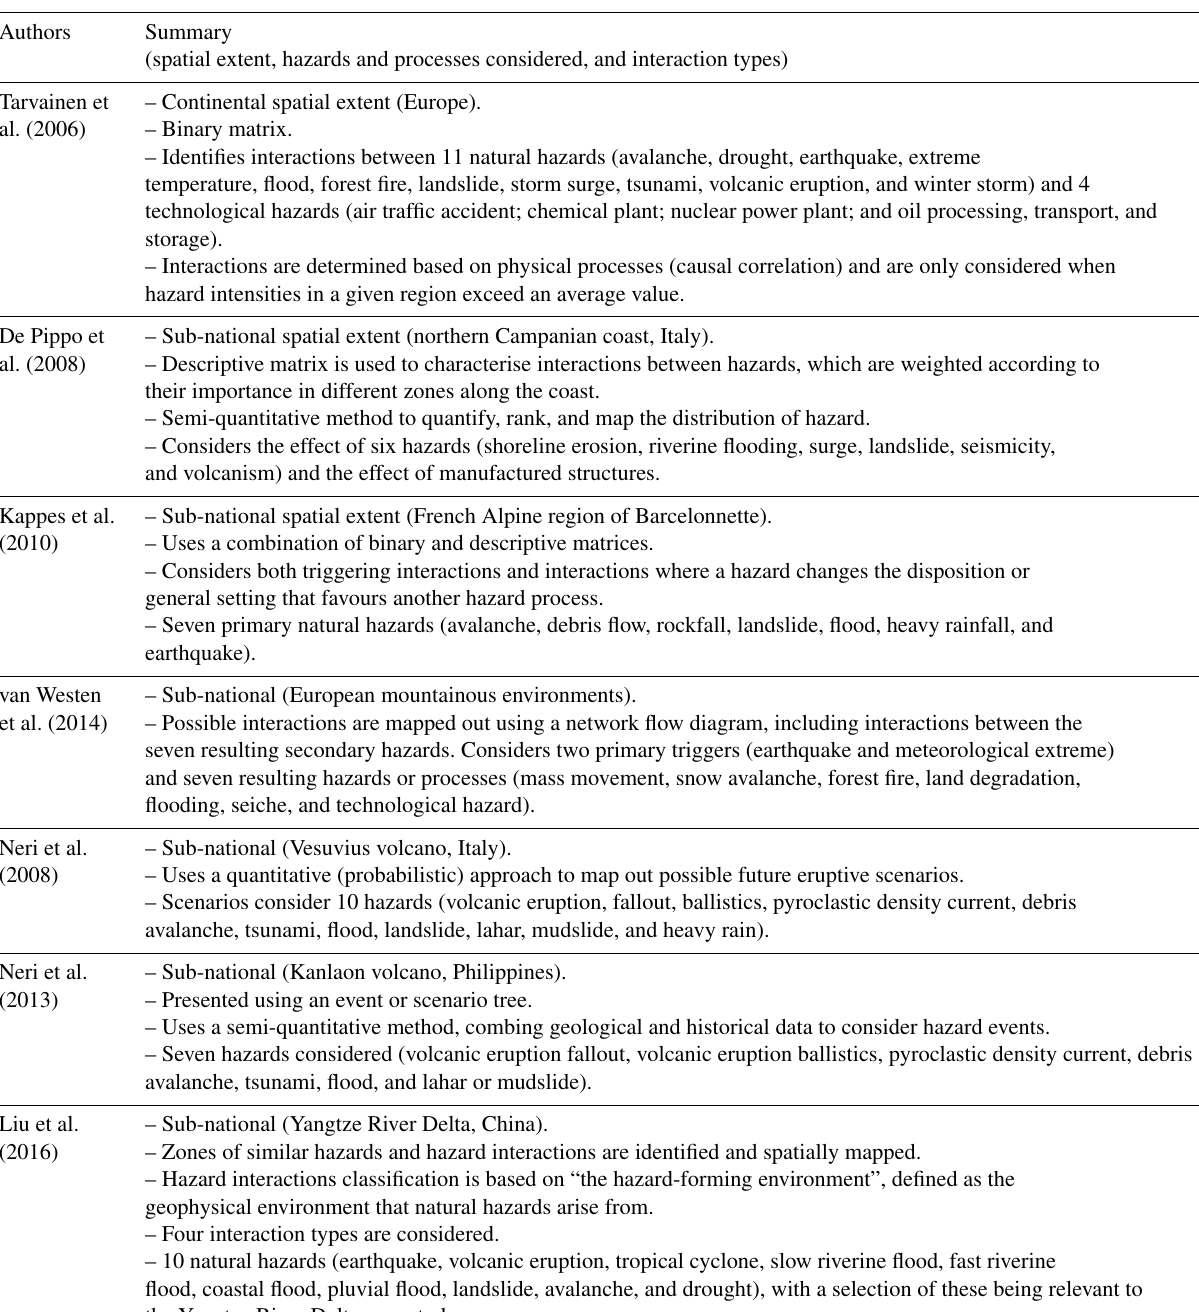
Table 1. Examples of seven regional interaction frameworks, including a summary of the spatial extent, hazards and processes considered, and interaction